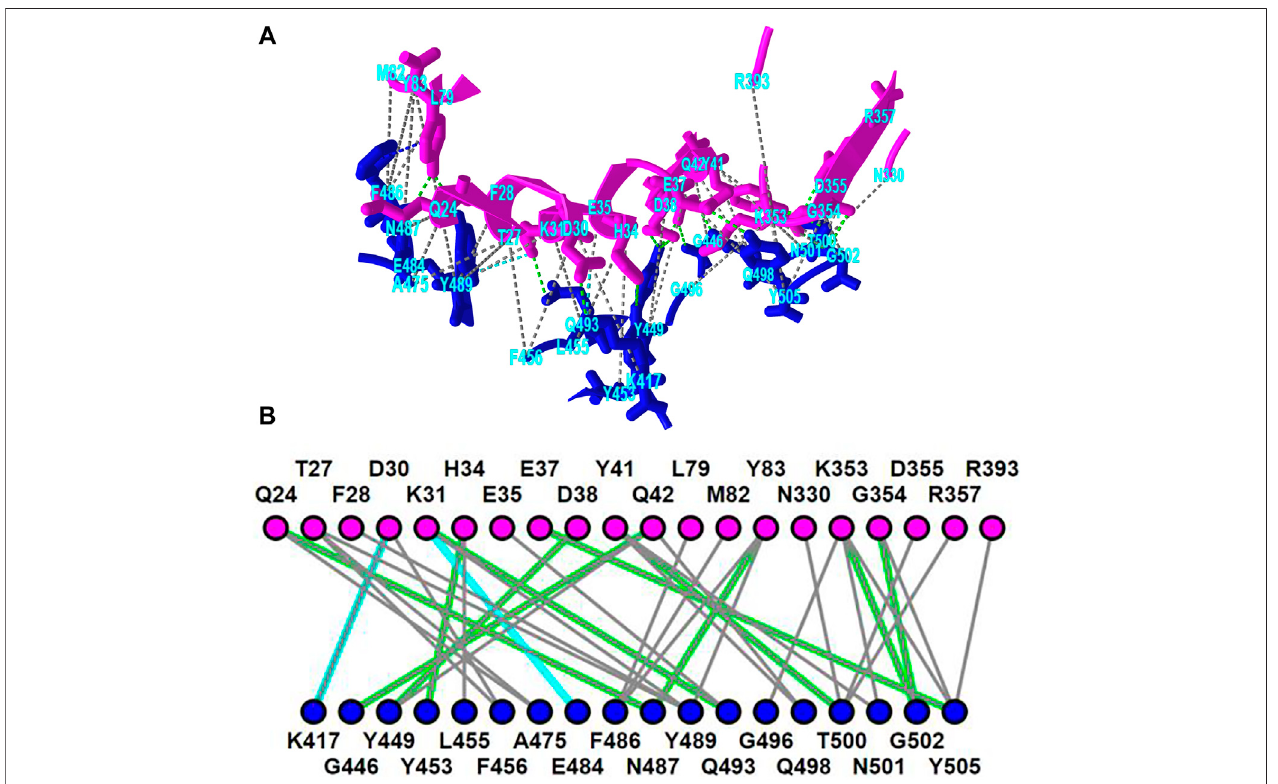
FIGURE 2 | 3D and 2D views of the interaction between ACE2 (pink) and SARS-CoV-2 spike protein (blue) (PDB 6M0J). (A) 3D view of the interaction. Hydrogen bonds, salt bridges, and contacts are depicted as dotted lines and are colored in green, cyan, and gray, respectively. (B) 2D interaction network of the interaction. Each node and line can be clicked to show the corresponding residue and interaction in the 3D view. Sharable Link: https://structure.ncbi.nlm.nih.gov/icn3d/share.html?